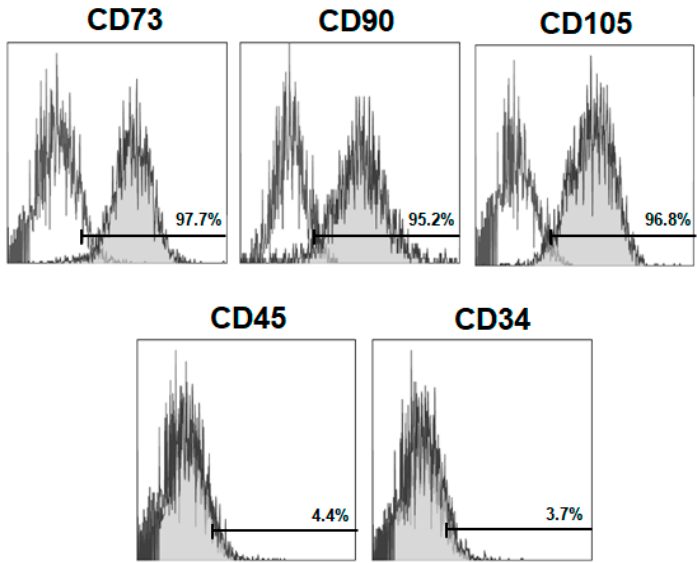
Figure 1. Rat bone marrow-derived-MSCs (BM-MSCs) express the typical mesenchymal stem cells (MSCs) markers CD73 (97.7%), CD90 (95.2%) and CD105 (96.8%), whereas expression of CD45 and CD34 were low or negative. Specific antibodies staining (light gray histograms) were compared with their corresponding control isotypes (white histograms). Values inside histograms represent percent of positive cells for each specific marker.